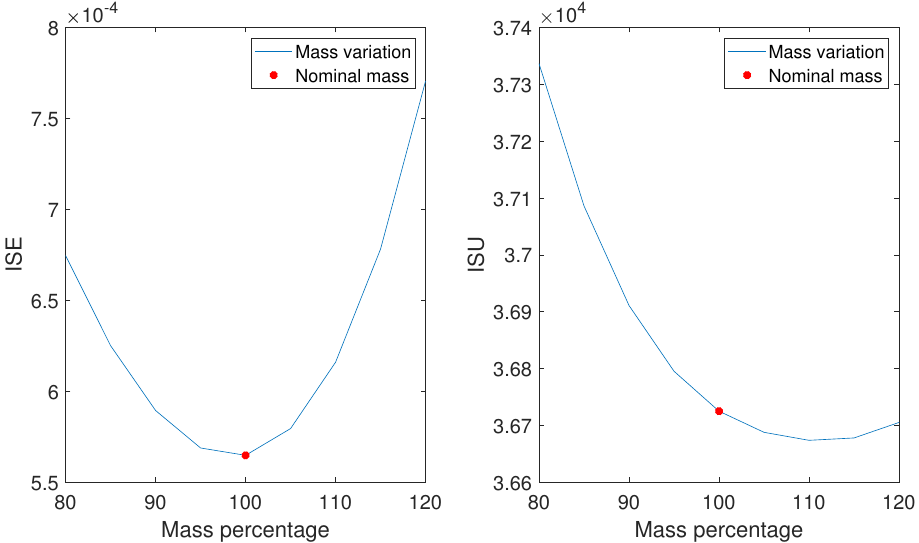
Figure 10. Robustness and performance indexes with parameter variation.